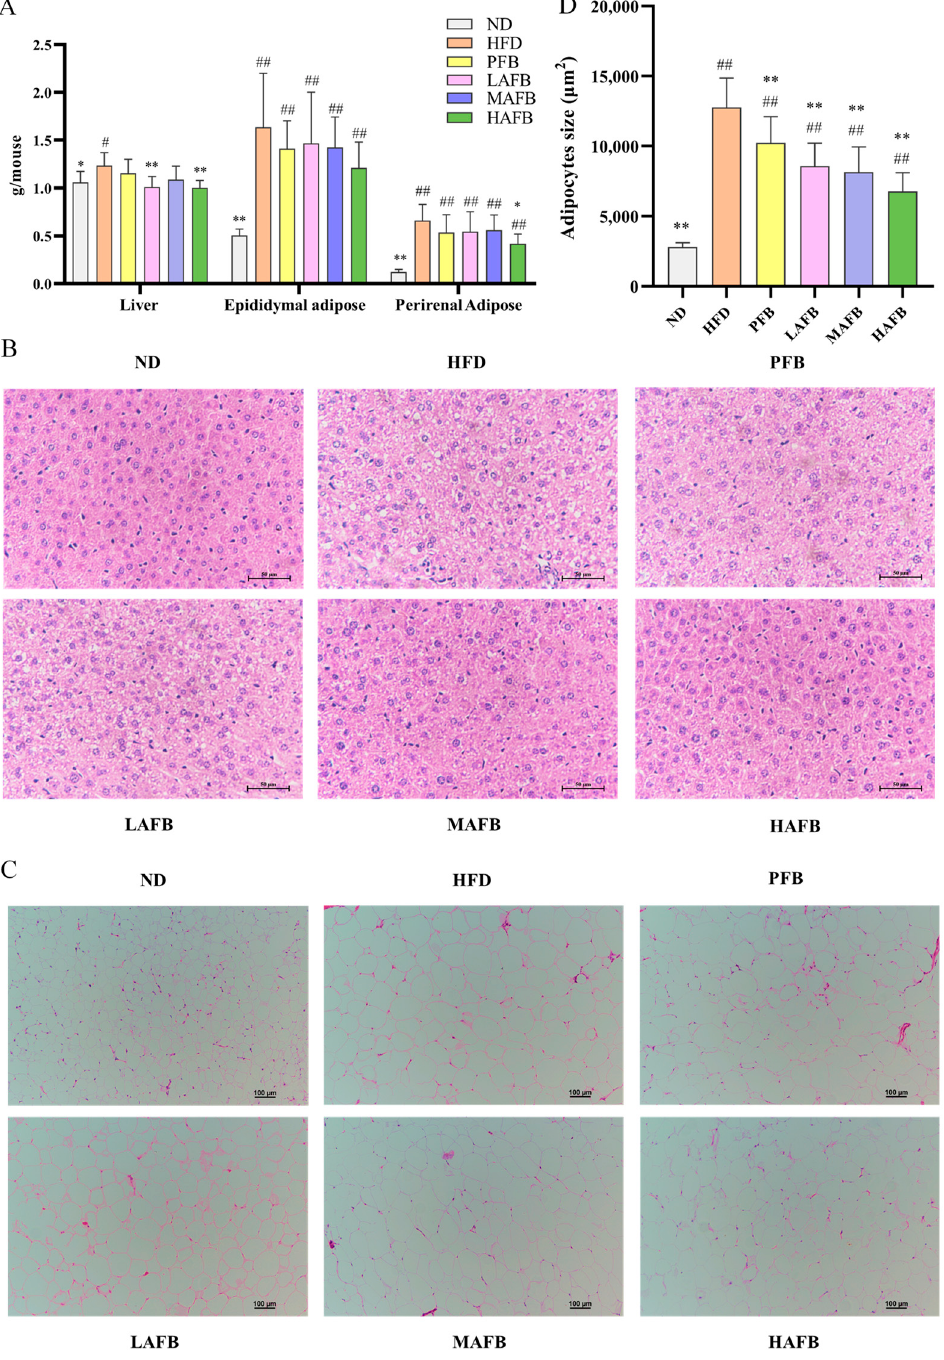
Figure 3. Effect of AFB on tissue. ( A ) Weight of the liver, epididymal adipose, and perirenal adipose tissue. ( B ) H&E staining of the liver (400 × ). ( C ) H&E staining of epididymal adipose tissue (100 × ). ( D ) The size of the epididymal adipose tissue. The results are expressed as the mean ± SD. * p < 0.05, ** p < 0.01 versus the HFD group and # p < 0.05, ## p < 0.01 versus the ND group by one-way ANOVA.